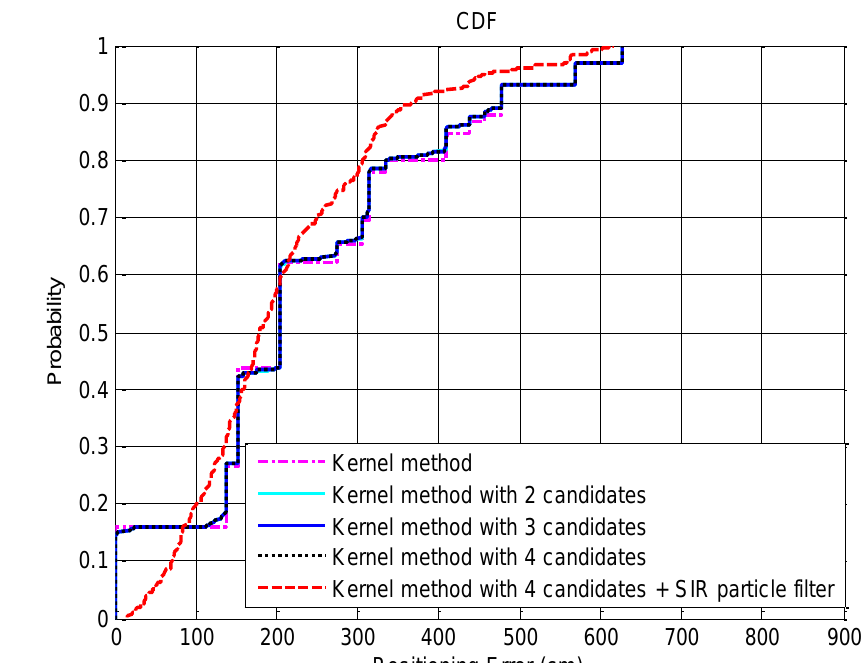
Figure 11. The CDFs of the positioning errors by the kernel